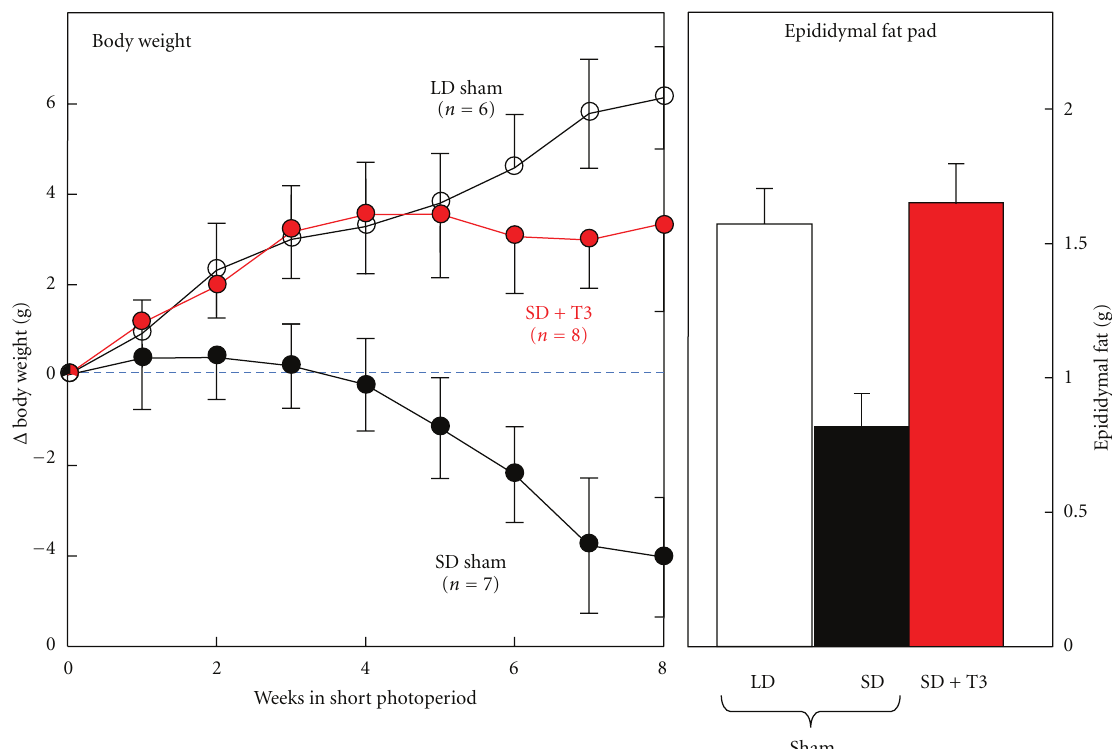
Figure 2: E ff ects of intrahypothalamic microimplantsreleasing tri-iodotyronine (T3) on body weight (left) and epididymal weight (right) in hamsters transferred to short days (SD+T3). Hamsters receiving sham implants were also transferred to short days (SD sham) or maintained in long days (LD sham). Note that SD induced weight loss, reflecting a reduction of white fat depots as compared to hamsters maintained in LD, but that implants which increased hypothalamic T3 concentrations blocked this SD-induced catabolic response. Modified from Barrett et al.